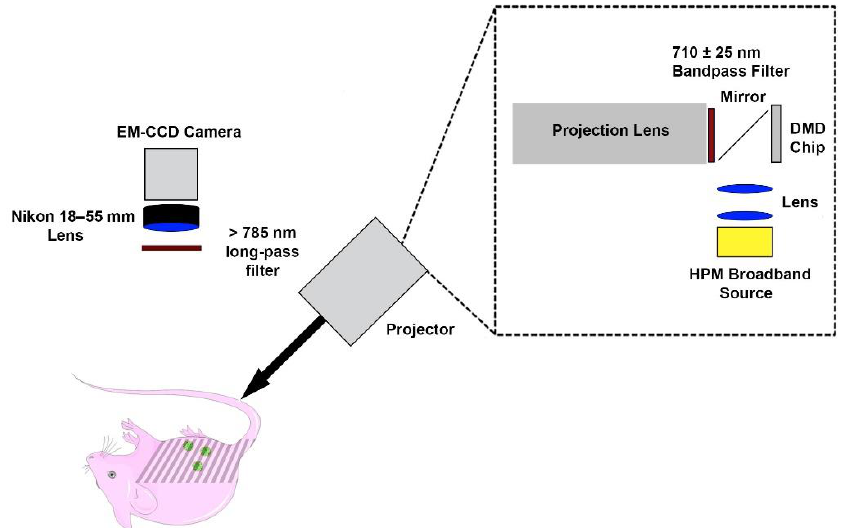
Figure 1. Spatially-modulated illumination system for fluorescence imaging of intraperitoneal ovarian tumors.